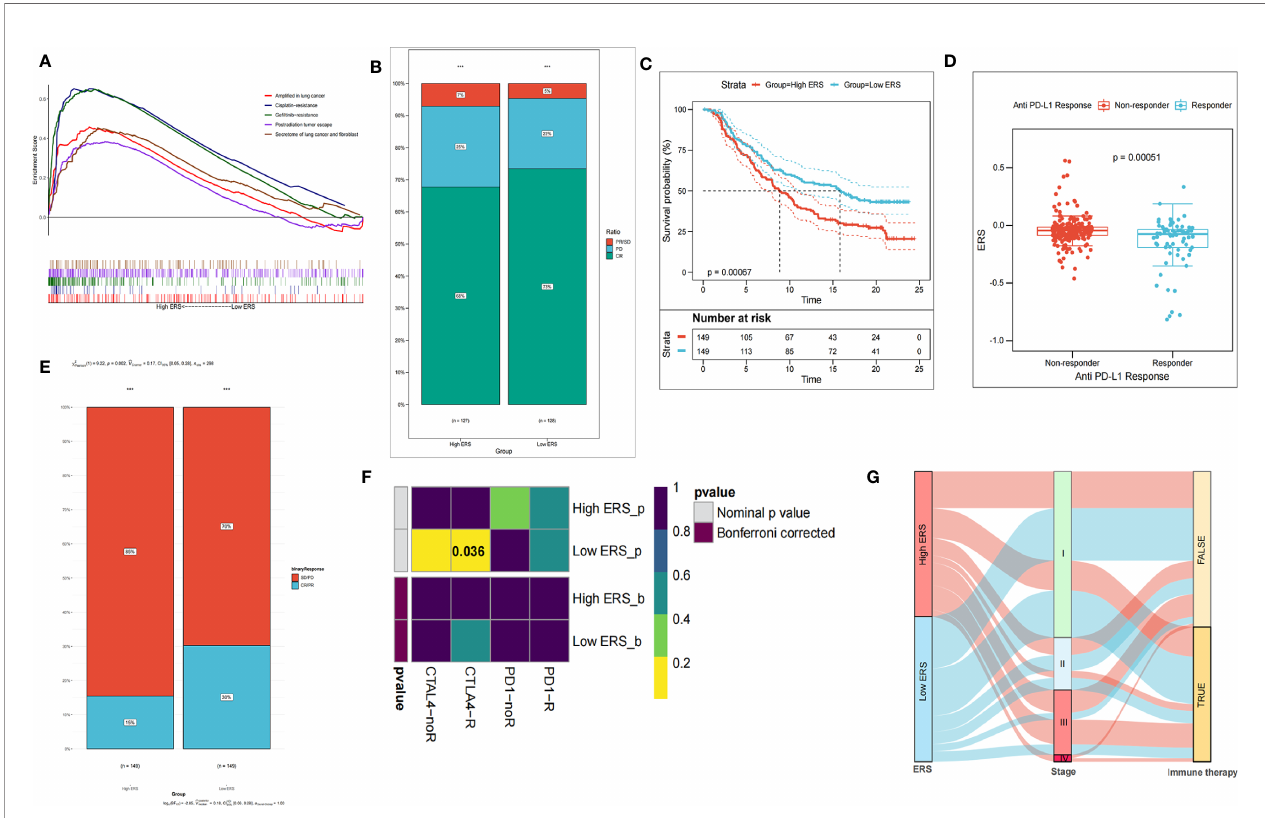
FIGURE 6 | ERS gene signature is a promising biomarker of resistance to different treatments. (A) GSEA predicts the correlation of gene signature with resistance to chemotherapy and resistance to radiotherapy. (B) The proportion of adverse postoperative outcomes increased in the high-ERS group. (C) In the IMvigor210 cohort, the prognosis of patients with higher ERS was remarkably worse. (D) ERS scores of groups with different anti-PD-1 clinical responses. (E) In the IMvigor210 cohort, the patients with higher ERS to anti-PD-L1 immunotherapy exhibited a lower clinical response rate. (F) Heat map displayed response to immunotherapy. (G) Sankey diagram showed the immunotherapy response predicted by the TIDE algorithm. ***P <